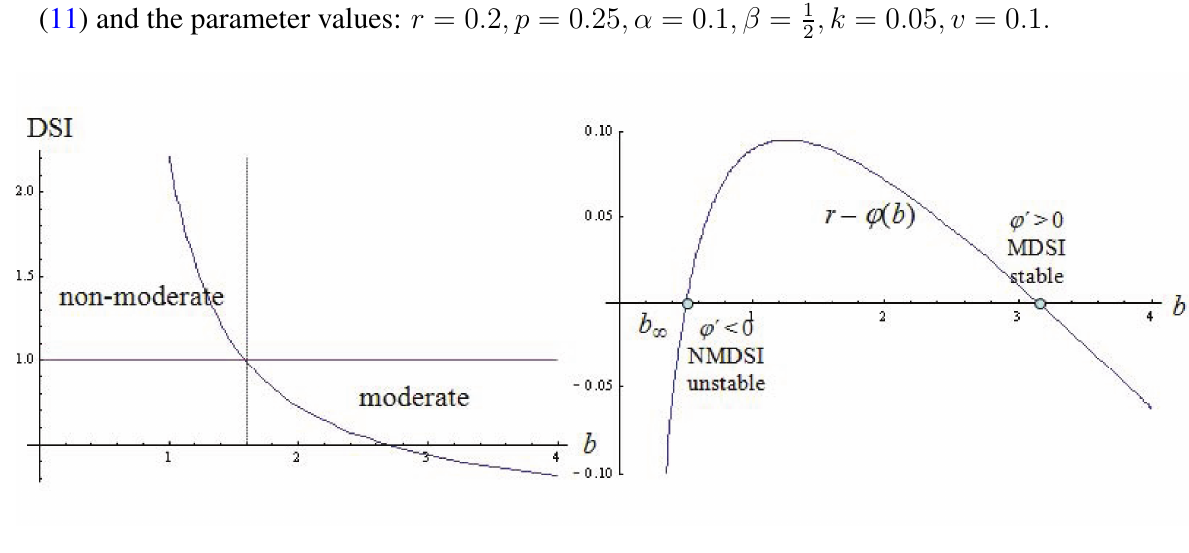
Figure 1. Dynamic social influence ( DSI ) and determination of steady states for the example (11) and the parameter values: r = 0 . 2 , p = 0 . 25 , α = 0 . 1 , β = 1